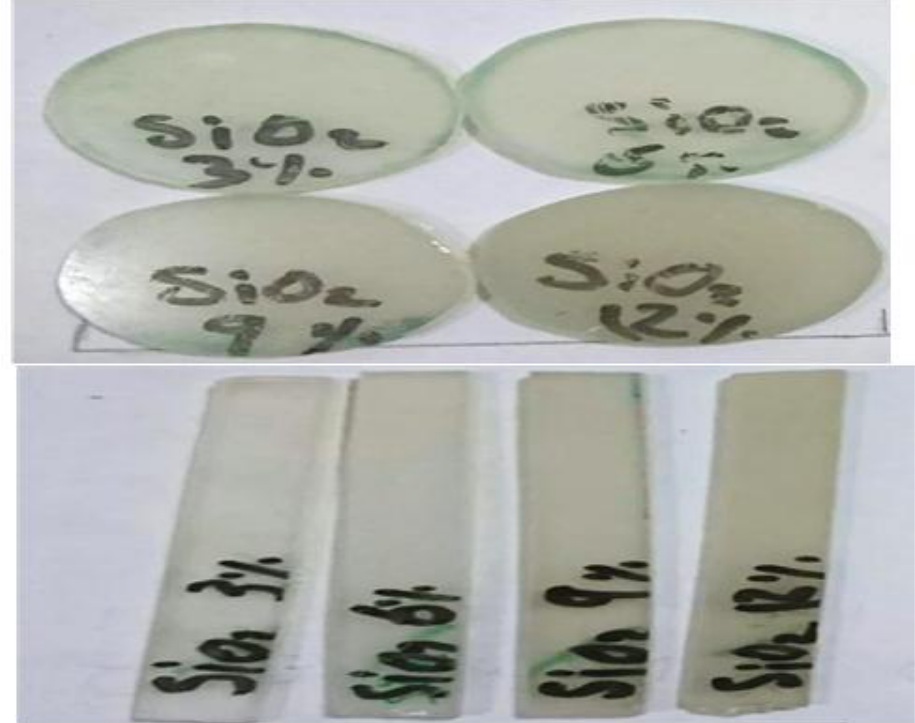
Fig.4: Photography of thermal conductivity and Impact strength